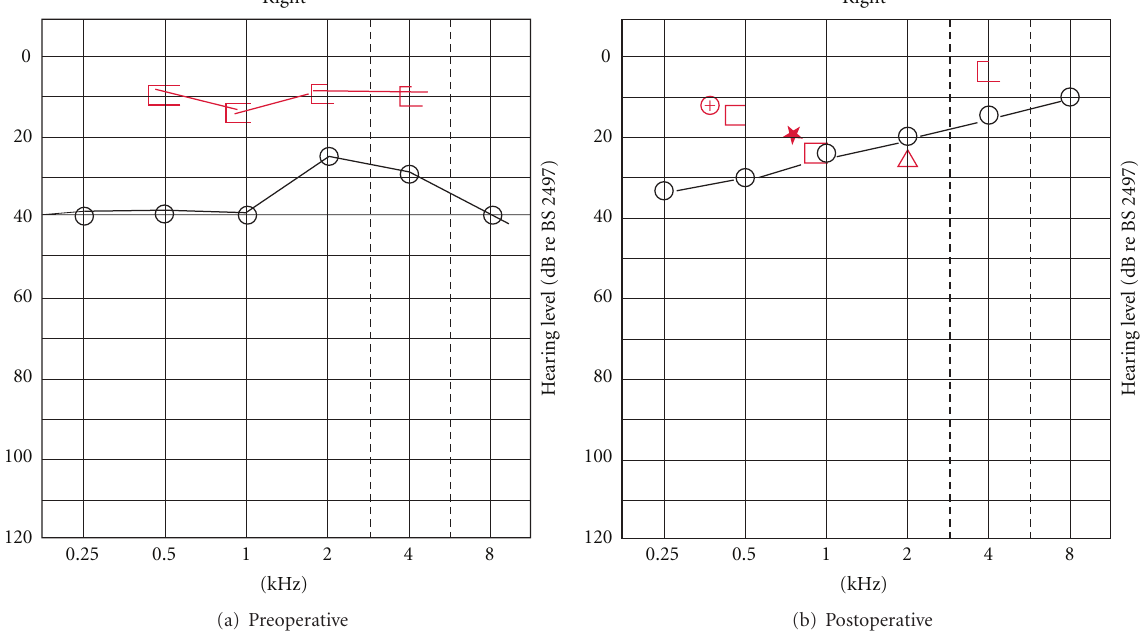
Figure 1: Pre- and postoperative pure-tone audiogram.